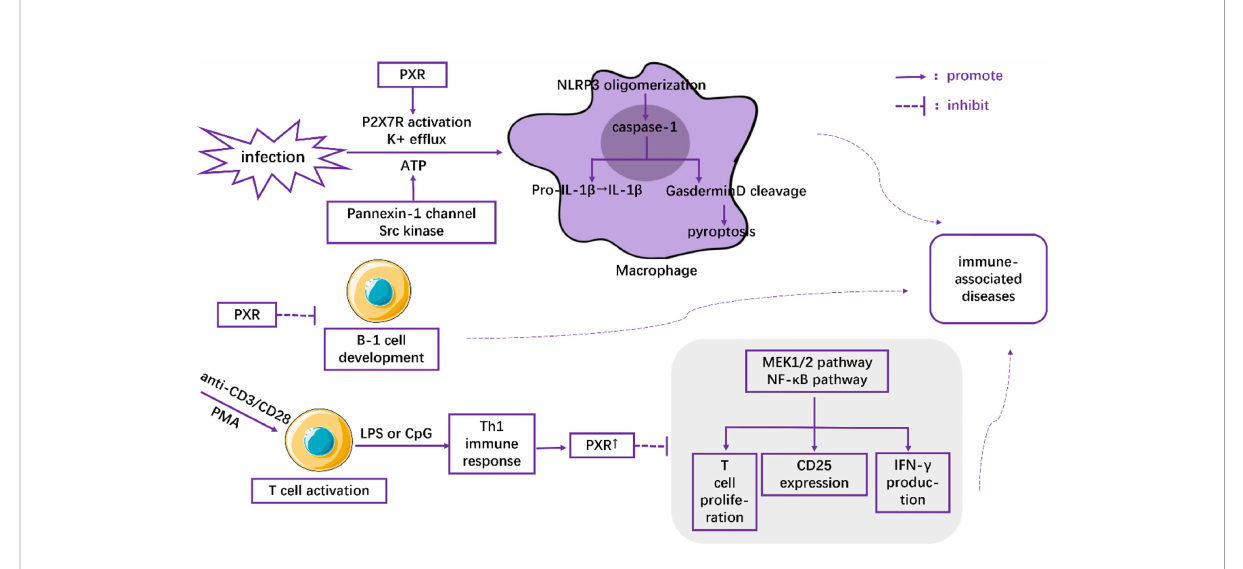
FIGURE 1 The role of PXR in the regulation of immune